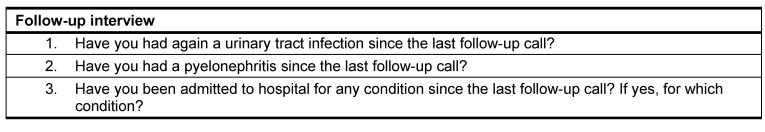
Follow-up: questions